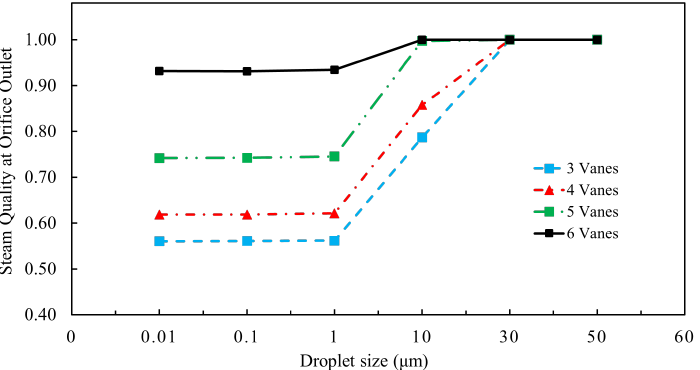
Figure 15. Pressure drop between the inlet and outlet for various vane quantities.